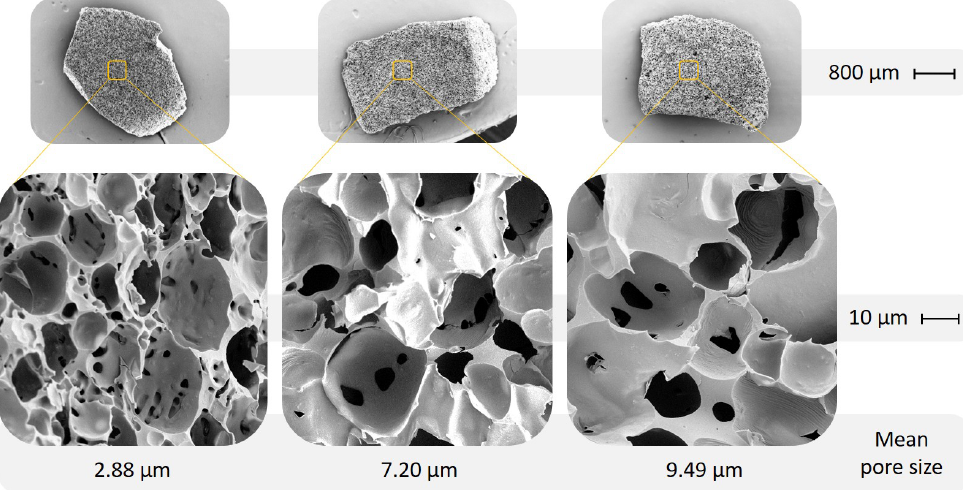
Figure 2. Scanning electron microscopy images of coffee granules showing the gas bubble size and the size of the interconnecting pores, left behind by ice